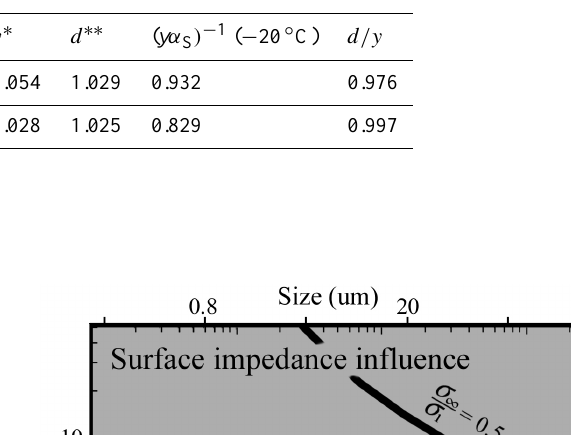
Table 1. Fractionation factors in Eqs. (8) and (9).